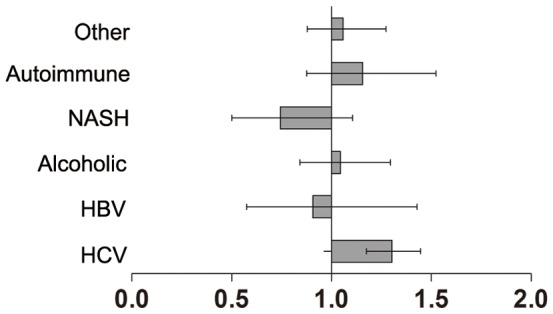
Hazard ratios (with 95% CI) to compare the risk of graft loss after liver transplantation in recipients from diabetes mellitus (DM) donors with various types of underlying liver diseases.